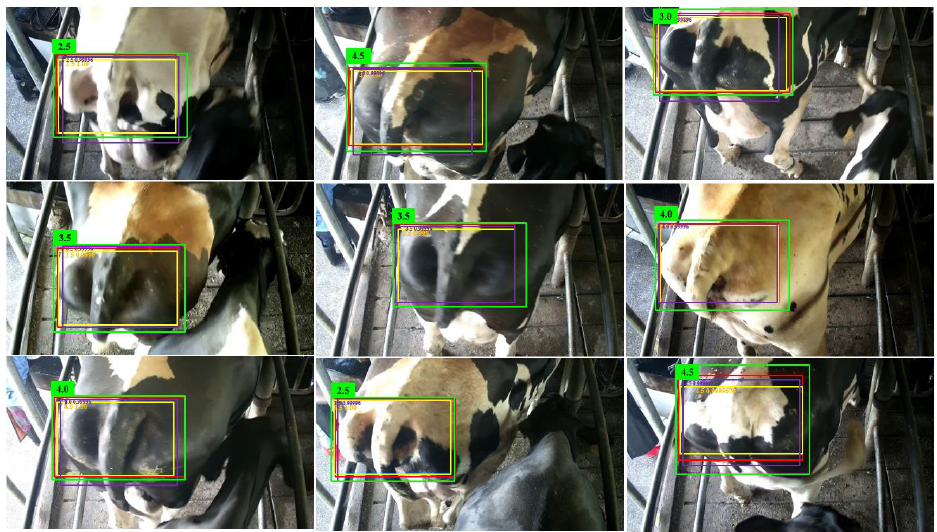
Figure 8. Examples of cow tail detection on the CTD test data set using our SSD, the original SSD and YOLO-v3 method. Each output box is associated with a category label and a BCS score in [2.5, 3.0, 3.5, 4.0, 4.5], one color corresponds to one kind of method in that image.